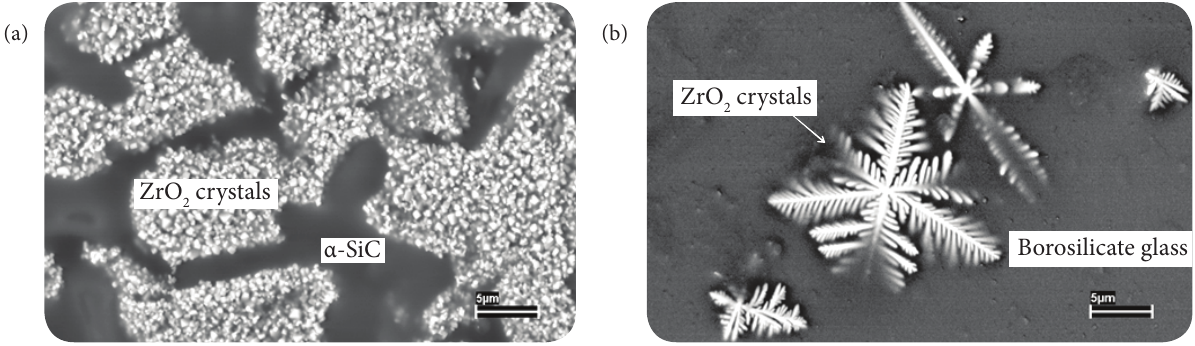
Figure 11. SEM images of the surface of AZ-30SiC composite after oxidation: (a) 1100 °C/4h; (b) 1400